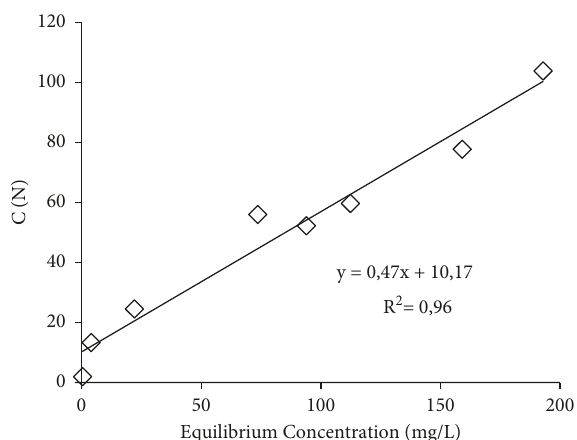
Figure 4: Copper(II) adsorption based on the Langmuir isotherm model.